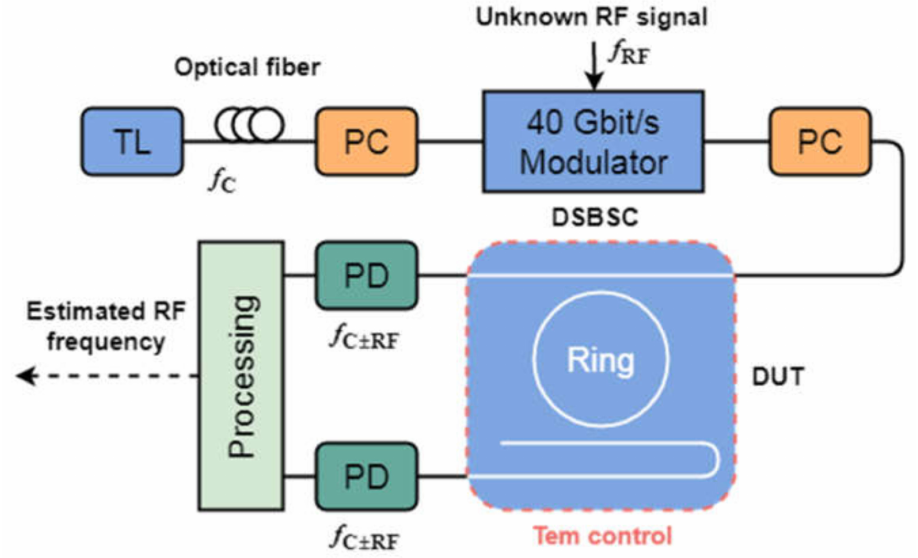
Figure 17. Schematic diagram of an IFM system based on a silicon microring resonator. TL— Tunable laser; PC—Polarization controller; DSBSC—Double sideband suppressed carrier modulation; DUT—Device under test; PD—Photodiode (Adapted with permission from Ref [32]. Copyright 2017,